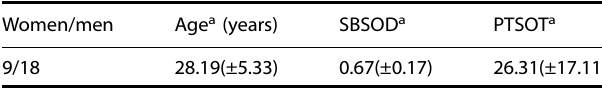
Table 1. Participant demographics and average orienting ability test scores at the initial